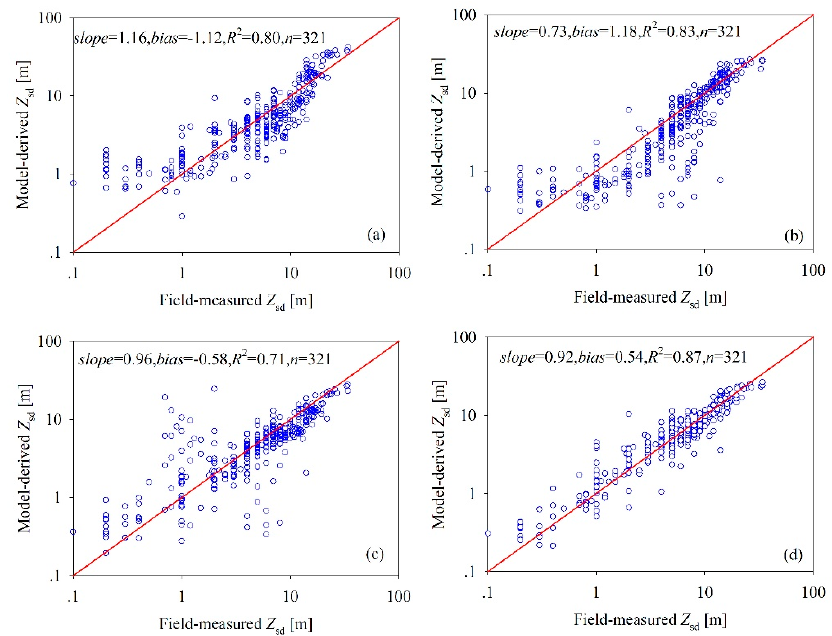
Figure 2. Scatterplots of field-measured against ( a ) blue-green Z sd (BGSD), ( b ) inherent optical properties (IOPSD), ( c ) minimum K d ( λ ) Z sd (MKSD), and ( d ) class-based scheme for Z sd (CSSD) models-derived Z sd for the initialization dataset in Table 1.